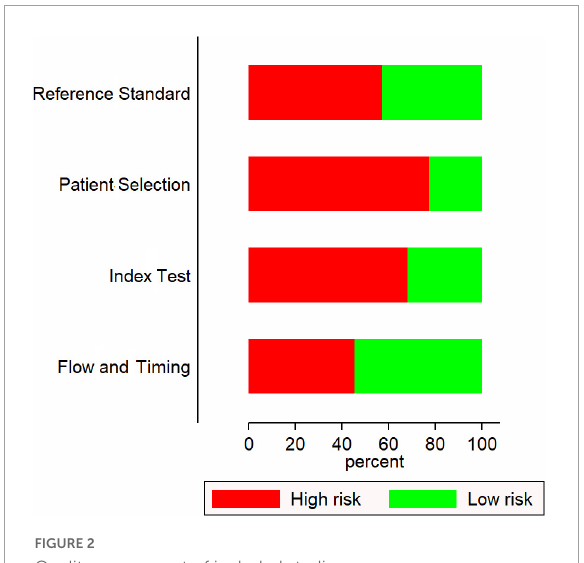
FIGURE2 Quality assessment of included